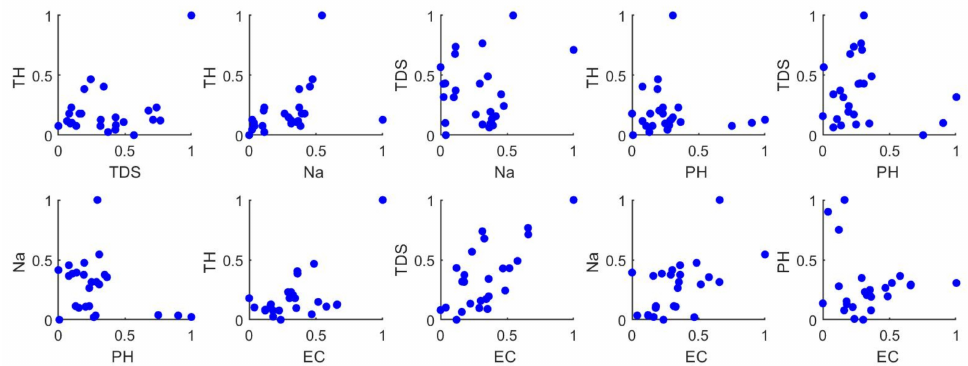
Figure 6. Bivariate scatter plots of the sampling (normalized) values obtained for some physicochem- ical water quality properties of the harvested